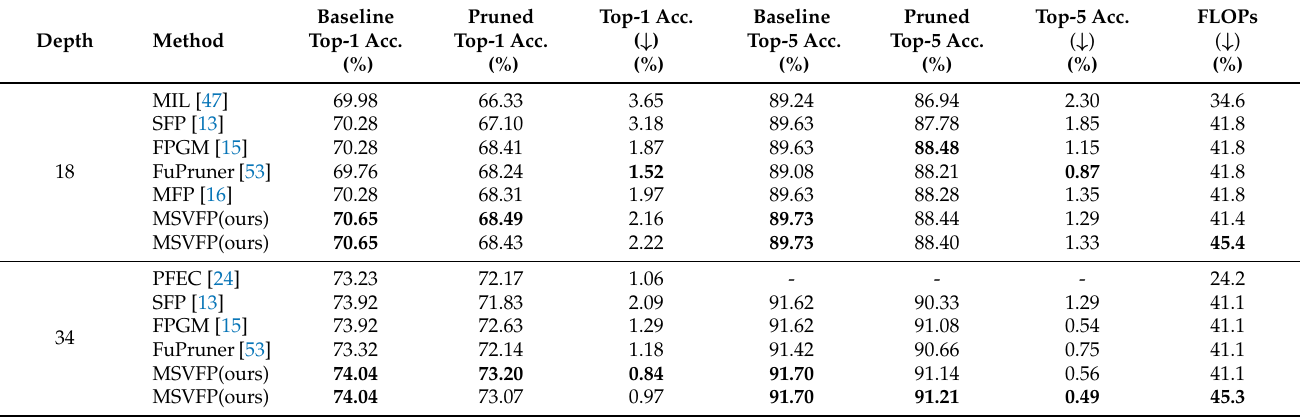
Table 5. Comparison of pruned ResNet models on ImageNet dataset. “FLOPs ( ↓ ) (%)” represents the FLOPs reduction rate between the baseline model and pruned model. “Acc. ( ↓ ) (%)” represents the accuracy difference between the baseline model and pruned